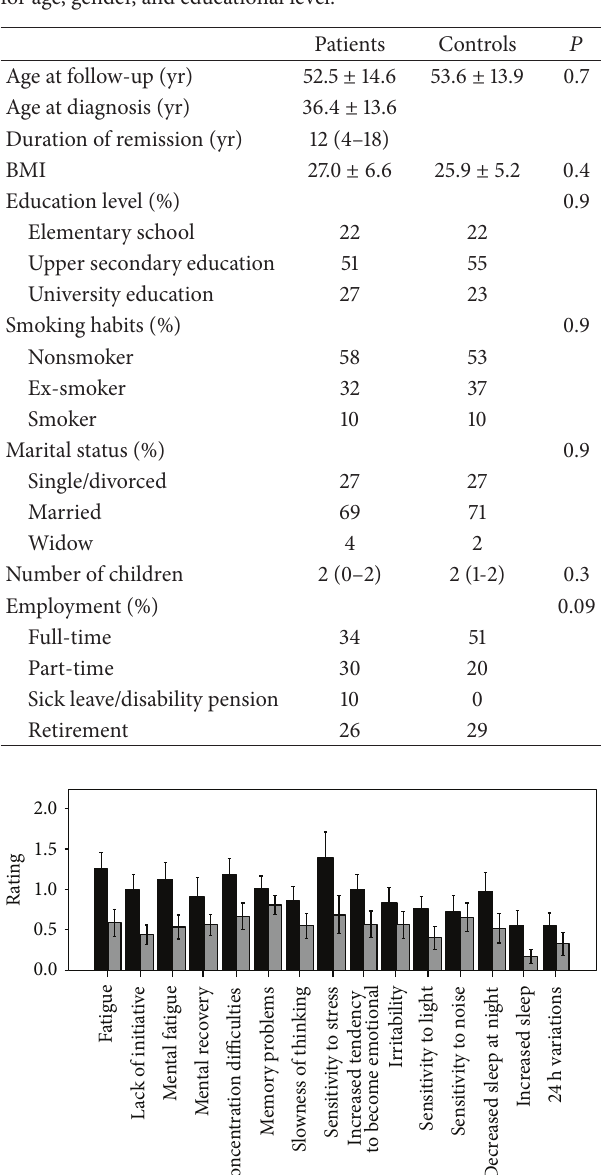
Table 1: Background characteristics and sociodemographic status in 51 patients with CS in remission and 51 healthy controls matched for age, gender, and educational level.